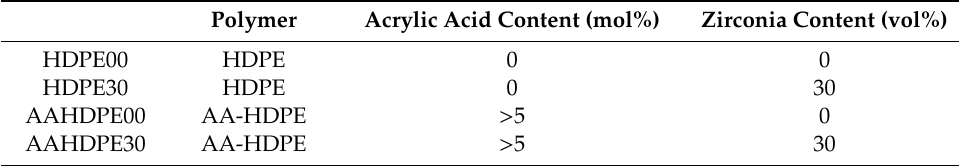
Table 2. Compounds prepared and